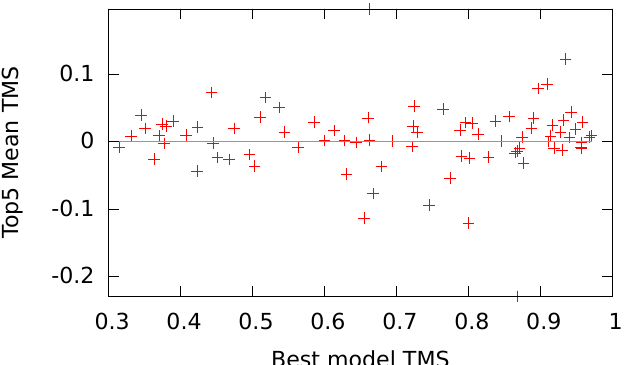
Figure 3. Difference in the top five mean TMSs between OUNRES and UNRES as a function of the TMS to native of the best available decoy for that target submitted during the CASP11 experiment. Smaller values on the x-axis indicate harder targets, while the y-axis measures the success of UNRES optimization, with higher values indicating greater